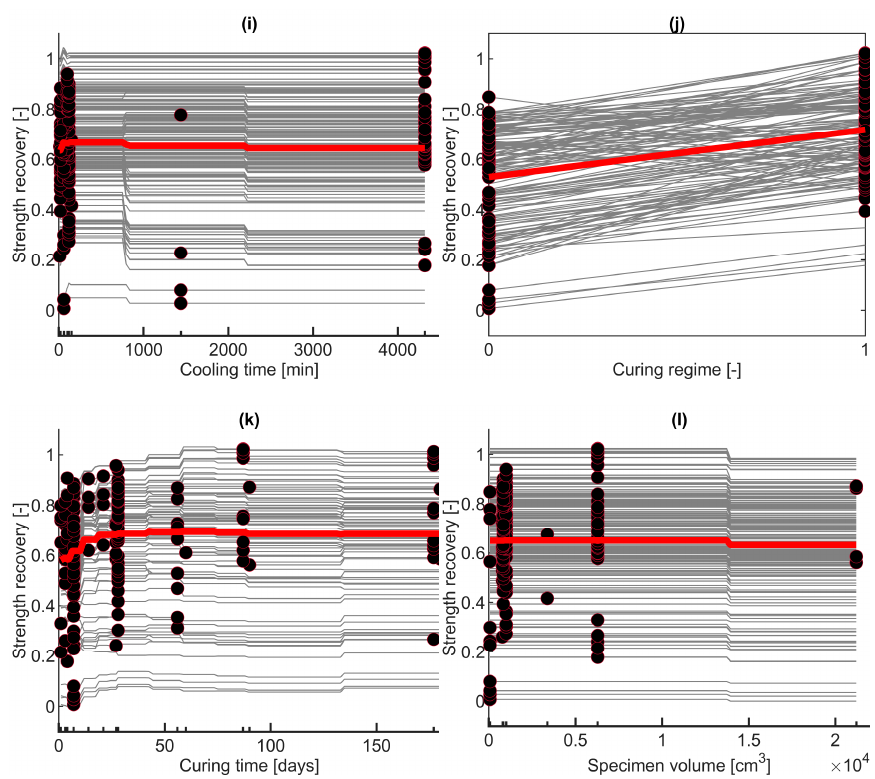
Figure 10. ICE plots for each input variable. The thick red curve depicts the PDP, i.e., the average of all the individual gray curves. Dots represent the measured value of the specific variable. ( a ) Water-to-cement ratio (I1), ( b ) age (I2), ( c ) cement amount (I3), ( d ) fine aggregate (I4), ( e ) coarse aggregate (I5), ( f ) temperature (I6), ( g ) duration of peak temperature (I7), ( h ) cooling regime (I8), ( i ) cooling duration (I9), ( j ) curing regime (I10), ( k ) curing duration (I11), ( l ) specimen volume (I12).